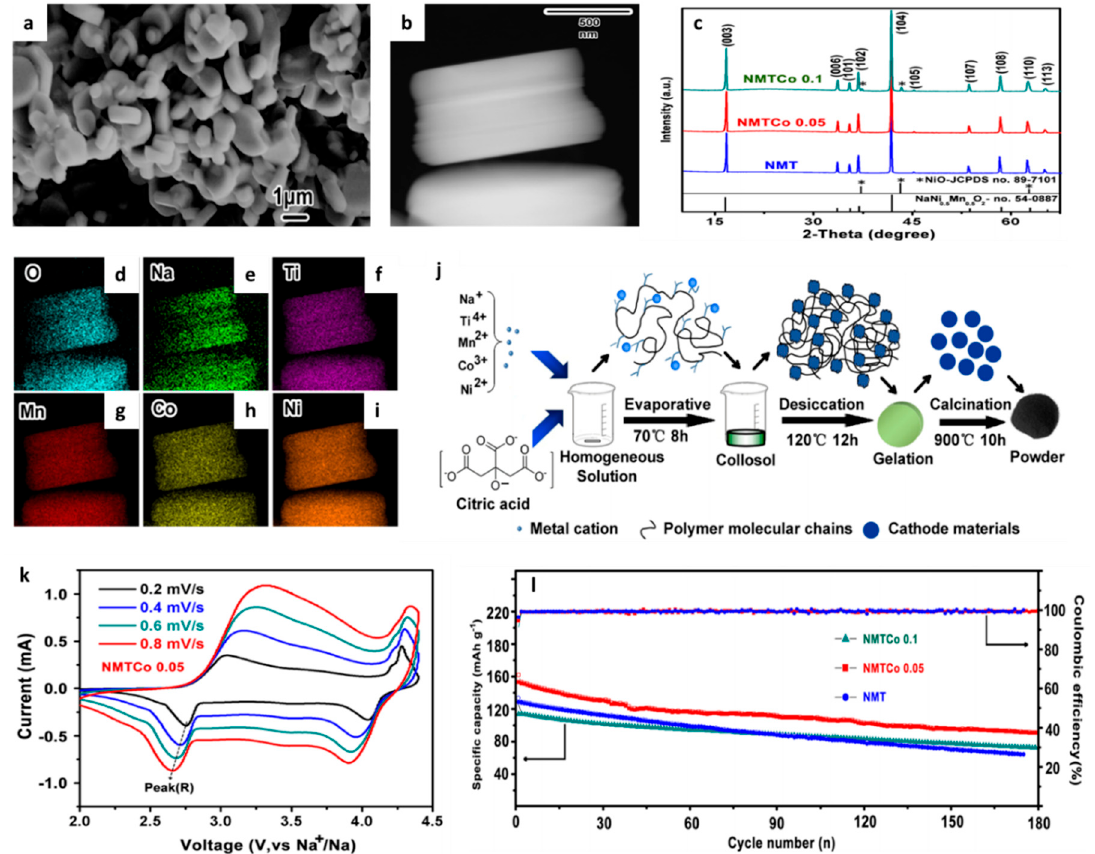
Figure 10 . Structural characterization and electrochemical performance analysis of NaNi 0.45 − x Mn 0.25 Ti 0.3 Co x O 2 (NMTCo x ) cathode in SIBs. ( a ) SEM images of the NMTCo 0.05 sample demonstrating particle sizes of approximately 1–2 µ m with a bead like morphology. ( b ) HRTEM image showing the morphology of the microparticle in greater detail. ( c ) XRD pattern of NMT samples with varying Co concentration (0, 0.05, 0.1) demonstrating the characteristic peaks, strong crystallinity and structural evolution. ( d – i ) Elemental maps of the microparticles with the constituent elements labeled. ( j ) Schematic representation of the steps in the synthesis process for the NMT samples. ( k ) Cyclic voltammetry curves of the NMTCo0.05 sample at progressively increasing scan rates (0.2–0.8 mV s − 1 ) with the characteristic redox peaks clearly visible. ( l ) Capacity retention and coulombic efficiency plots of the NMT cathodes over 180 cycles. Copyright 2019, American Chemical Society.